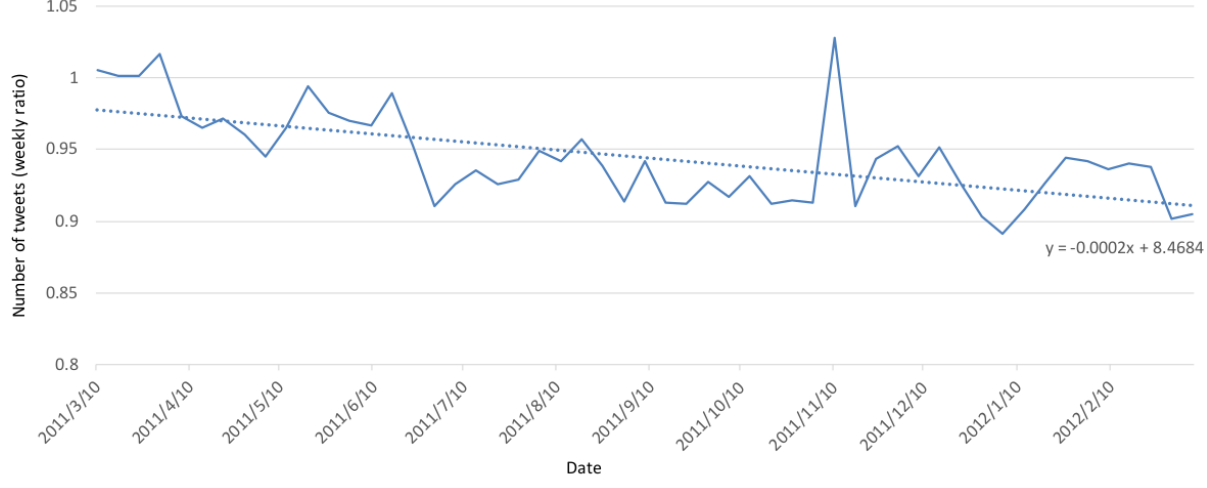
Figure 8. Weekly average ratio of semantic orientation values for Fukushima and other prefectures. The dotted line represents the linear approximation.